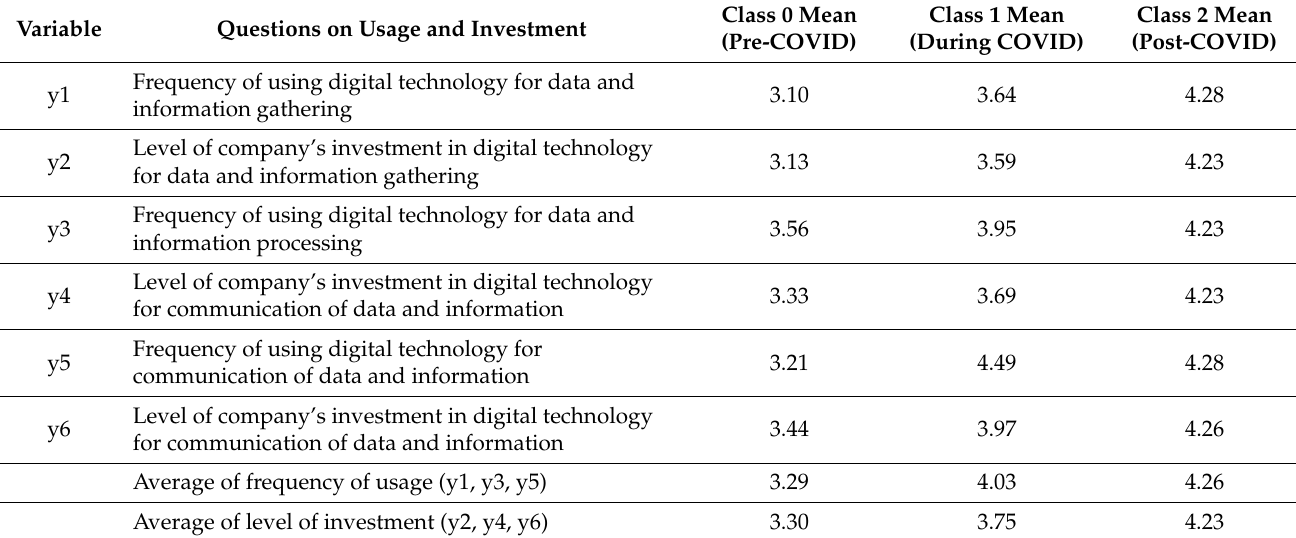
Table 4. Means of the responses of the three